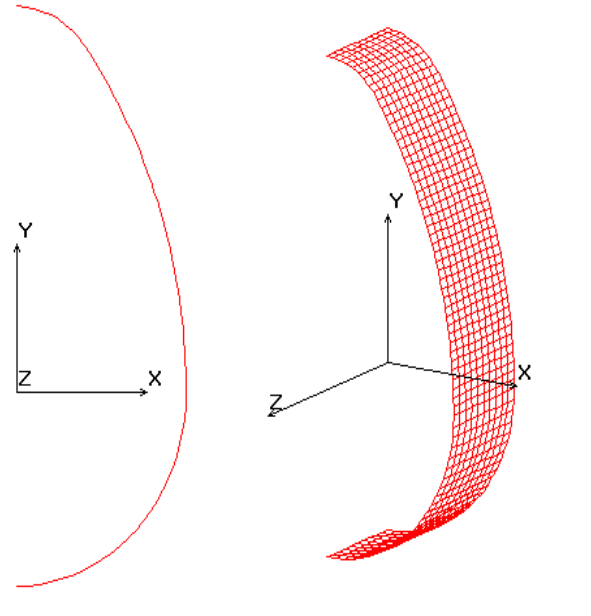
Figure 6: Calculation scheme of the finite element method.